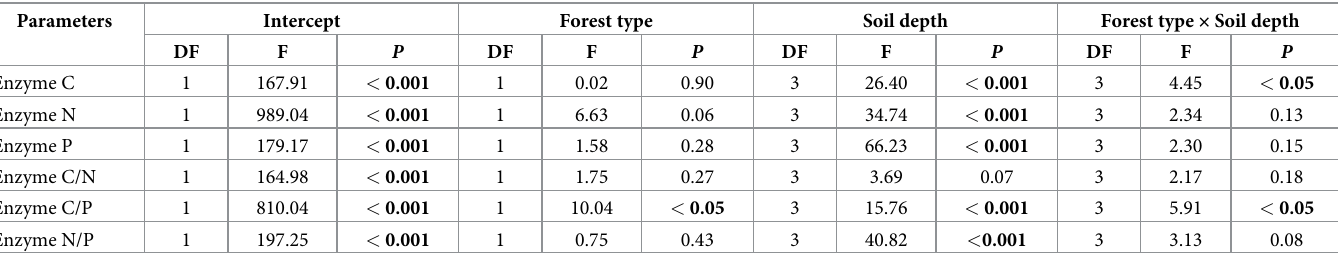
C acquisition enzyme was represented by the sum of β -1,4-glucosidase (BG), cellobiohydrolase (CBH), β -xylosidase (BX). The sum of β -1,4-N-acetylglucosaminidase (NAG) and leucine aminopeptidase (LAP) were used for N acquisition. Acid phosphatase (AP) represented P acquisition enzyme. Enzymatic stoichiometry of C/N, C/P and N/P was calculated by the C, N and P acquisition enzyme respectively. Significant results ( p < 0.05) are indicated in bold.